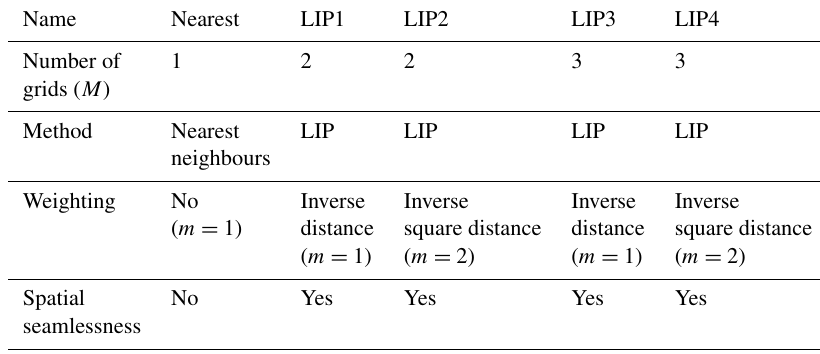
Table 2. Test experiments in the ensemble method for linear interpolation (LIP).